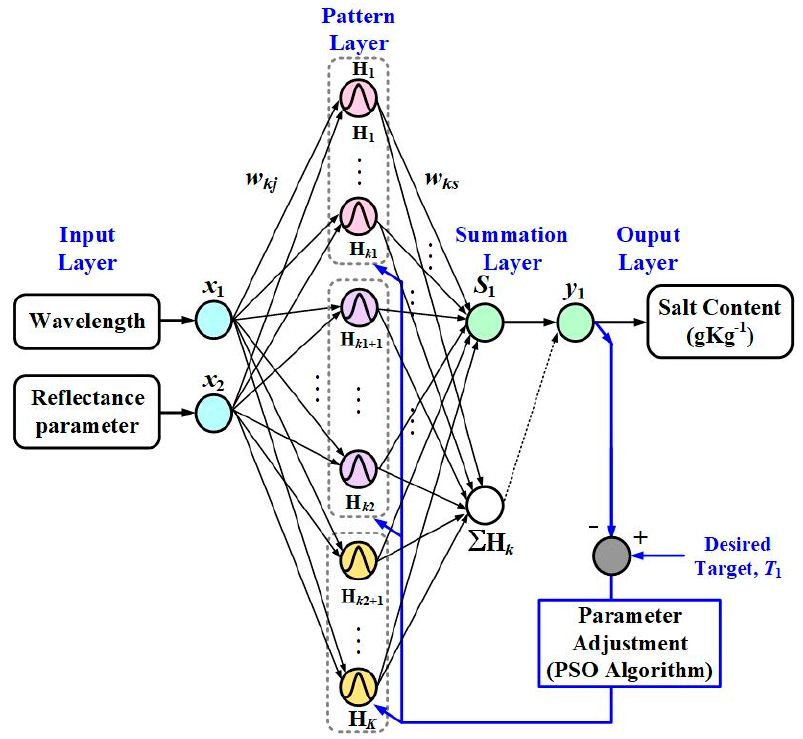
Figure 2. Neural network architecture.